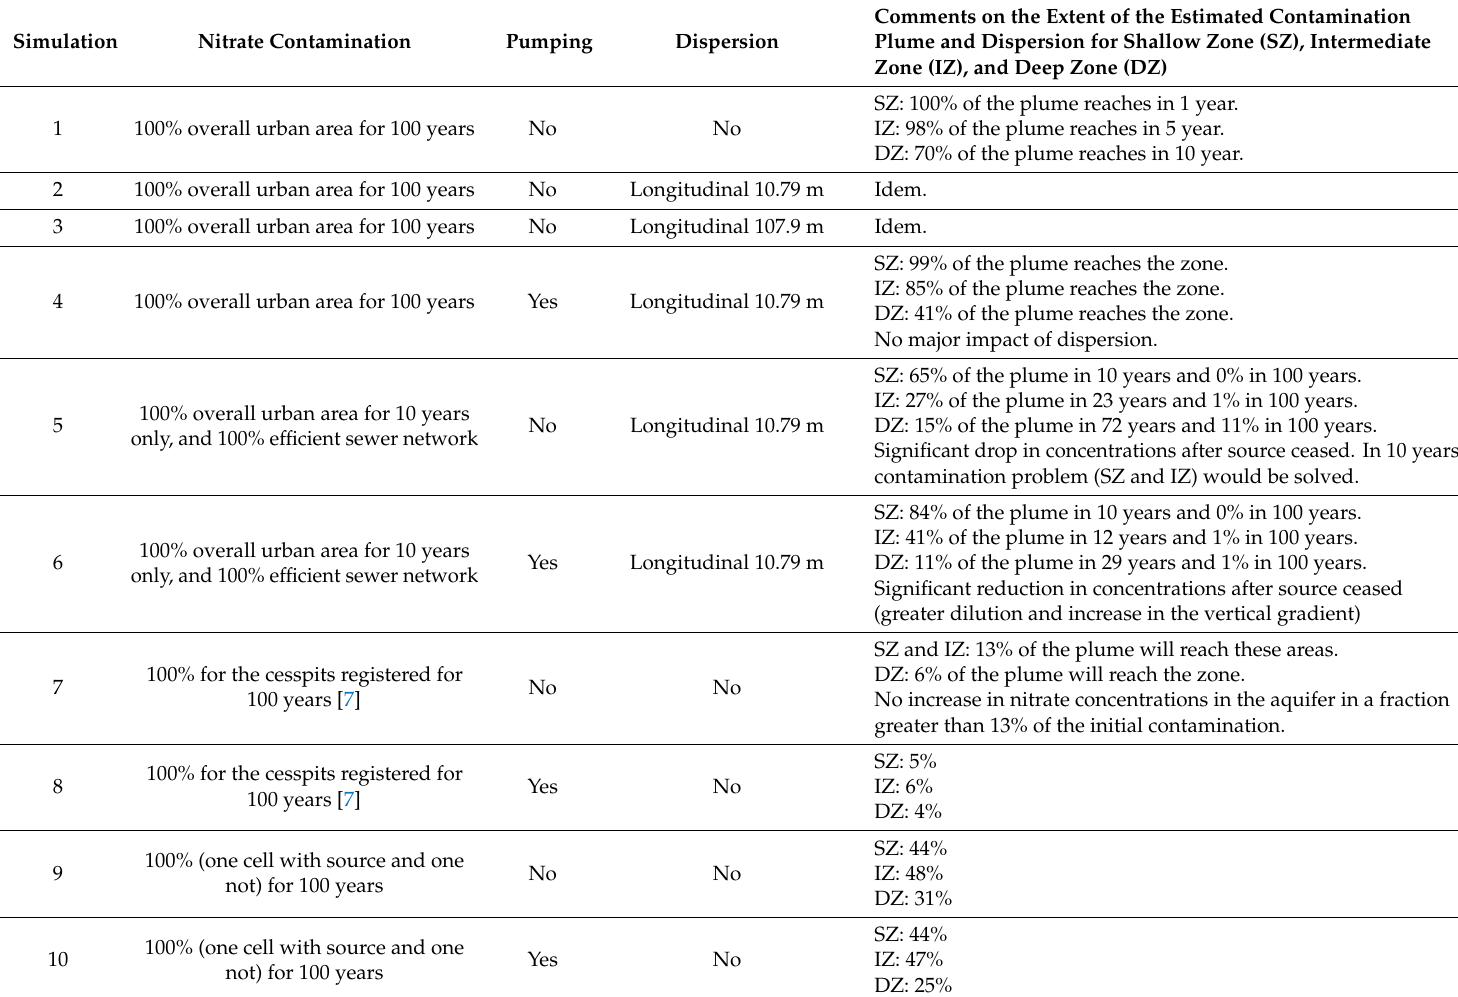
Table 5. Simulated nitrate distribution scenarios in the Adamantine Aquifer in Ur â nia. Comments on the Extent of the Estimated Contamination Pumping Dispersion Plume and Dispersion for Shallow Zone (SZ), Intermediate Zone (IZ), and Deep Zone